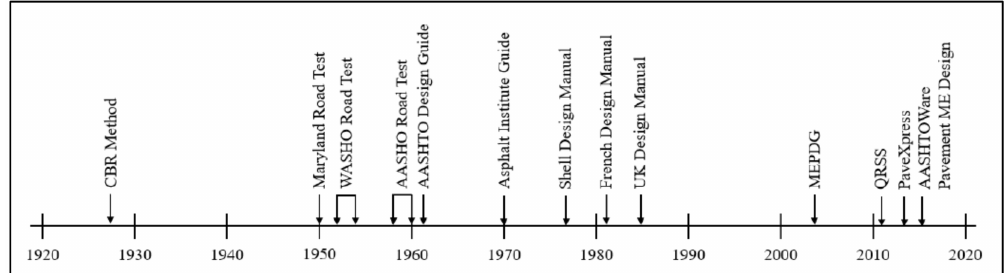
Figure 1. The development of flexible pavement design methods [18].